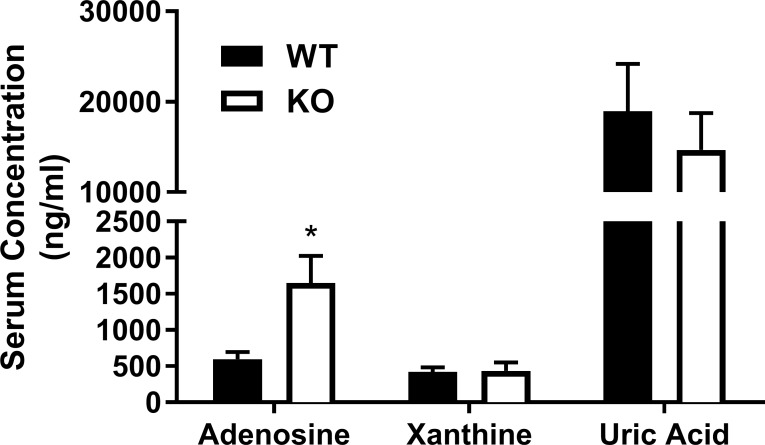
Plasma adenosine levels.Blood was obtained from wild-type (WT) and Slc29a1-null (KO) mice via cardiac puncture (in the presence of dilazep, EHNA and iodotubercidin to limit adenosine metabolism) and processed for HPLC analysis of adenosine, xanthine and uric acid content. *Significant difference between wild-type and Slc29a1-null mice for the indicated parameter (Student’s t-test for unpaired samples, two-tailed, P<0.05, N = 5).